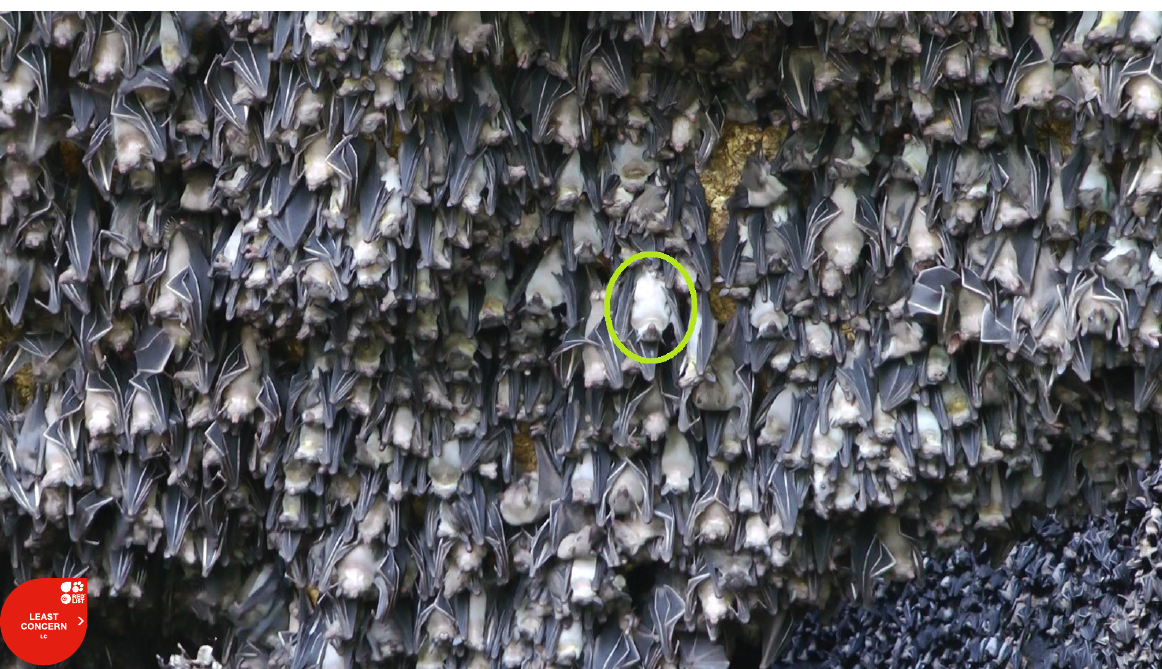
Image 1. Image of the parturition event observed August 27, 2011. The size and density of the colony makes it challenging to locate the female in labor so she has been outlined. At this point in the event, the pup’s head has already emerged and is visible. Image is a still captured from the video data collected by the authors.